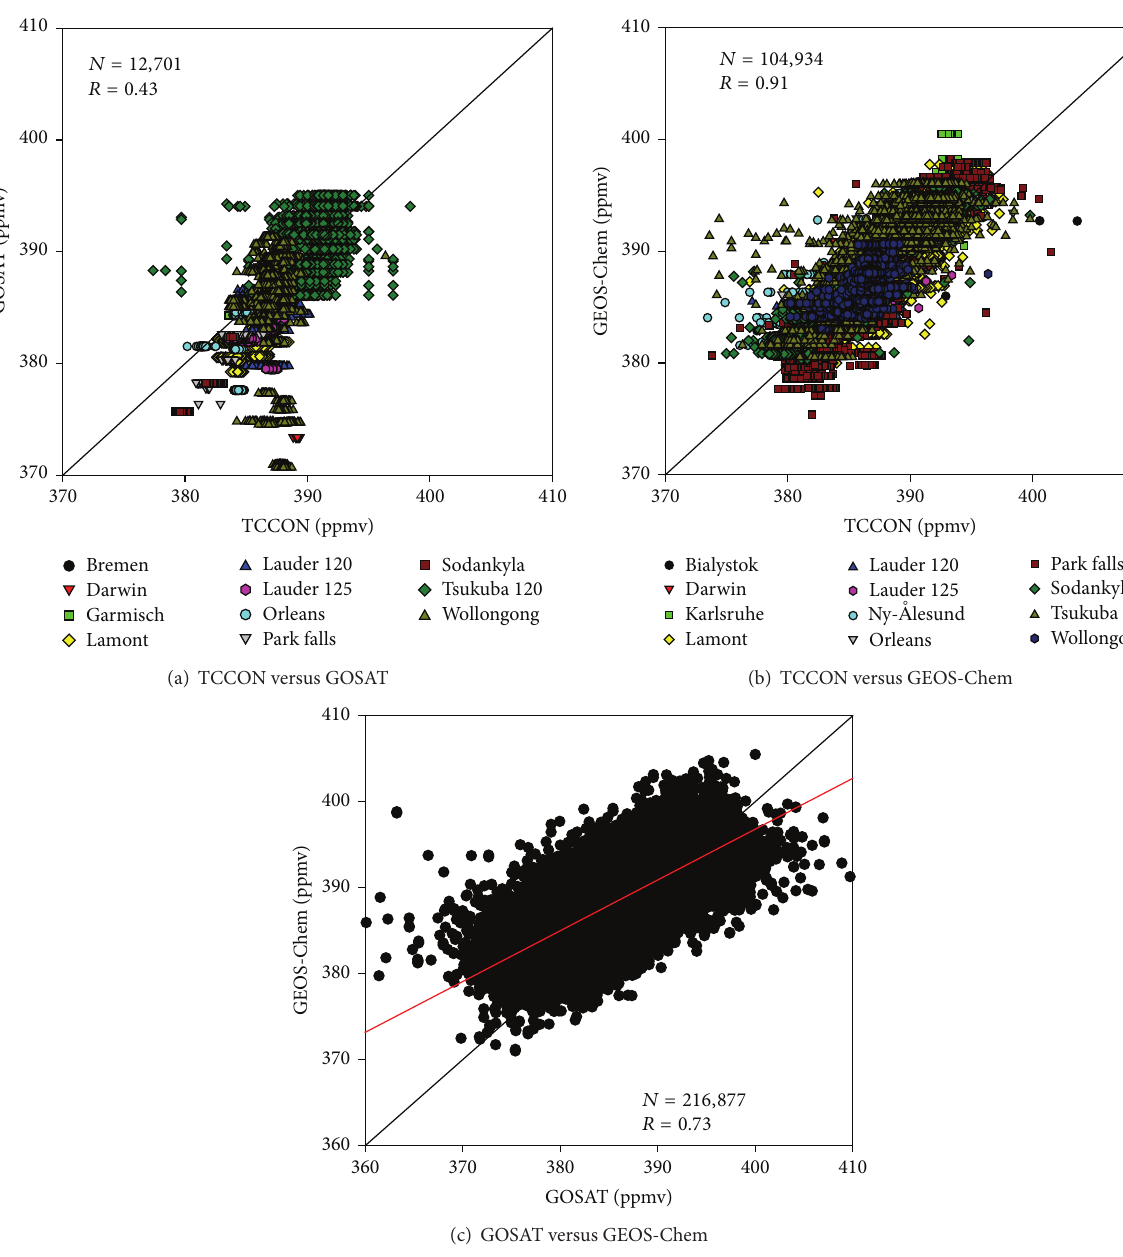
Figure2:Comparisonofthecolumn-averagedCO 2 concentration(a)betweenTCCONandGOSAT,(b)betweenTCCONandGEOS-Chem, and (c) between GOSAT and GEOS-Chem. 𝑁 and 𝑅 indicate number and correlation coefficient of matched data,